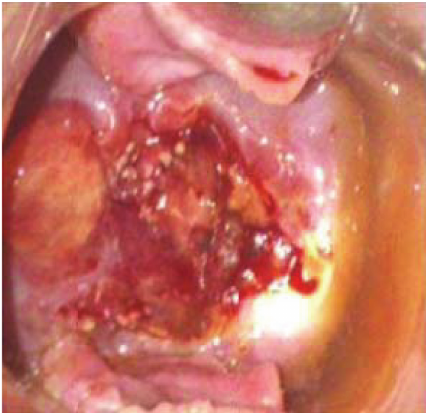
Figure 1: Abnormal cervical inspection.